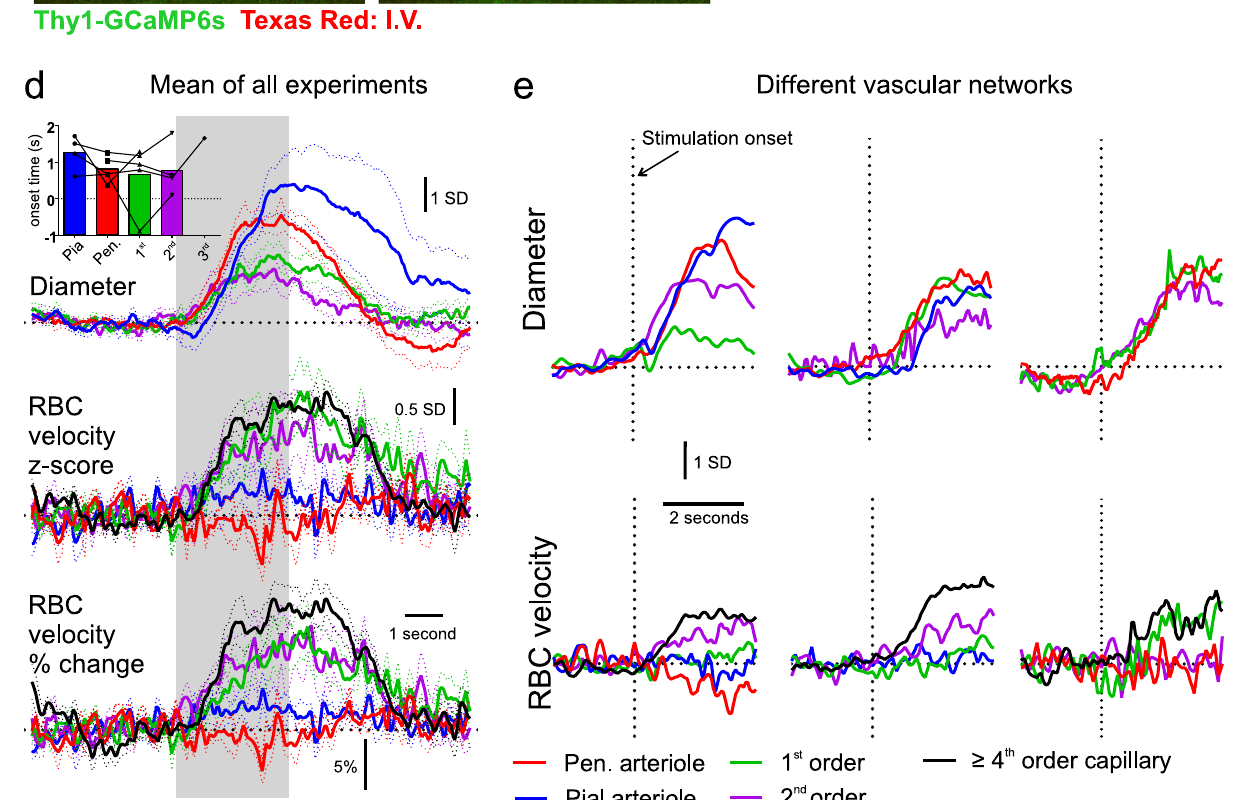
in activity-dependent blood- fl ow regulation 1 – 5,20 – 22 . It further highlights an increased level of complexity and the presence of functional diversity between branch orders of this transitional segment. In the mid-capillary bed, thin-strand pericytes do not express or express far lower levels of α -SMA actin 8 – 10,21 .